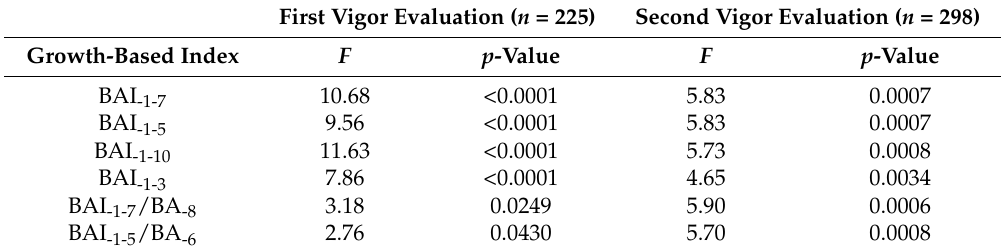
Table 3. Results of the analyses of variance (one-way ANOVAs) relating the most relevant growth-based indices to tree vigor classes. All models also included an intercept, the tree species (fixed effect), and a random site